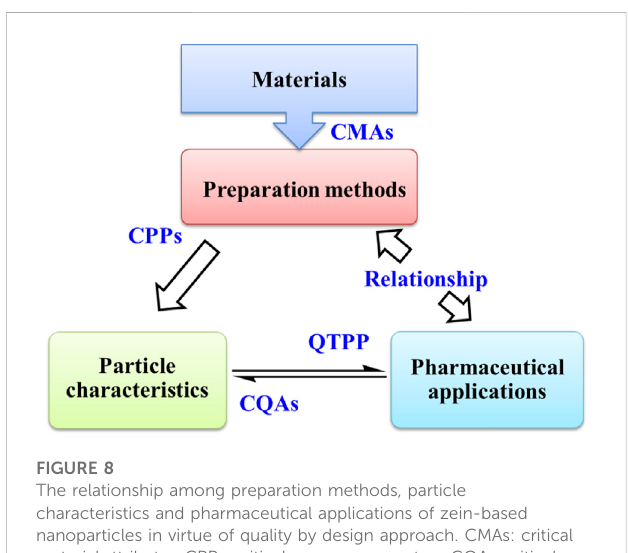
FIGURE 8 The relationship among preparation methods, particle characteristics and pharmaceutical applications of zein-based nanoparticles in virtue of quality by design approach. CMAs: